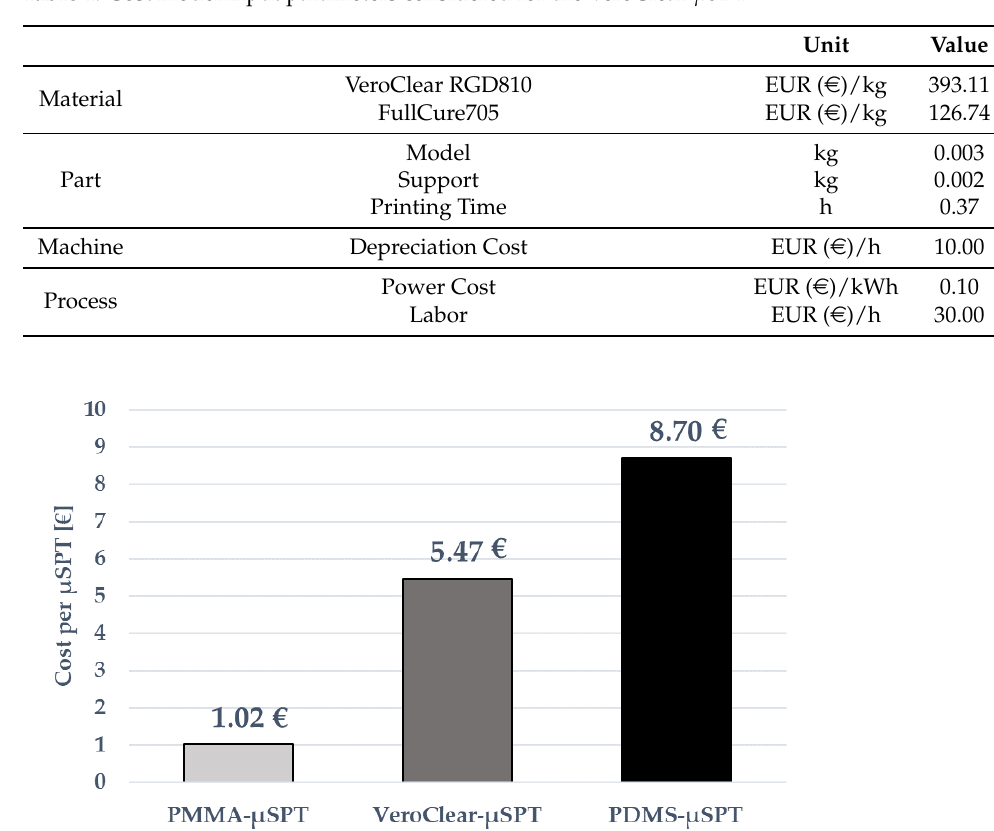
Table 4. Cost model input parameters considered for the VeroClear- µ SPT .